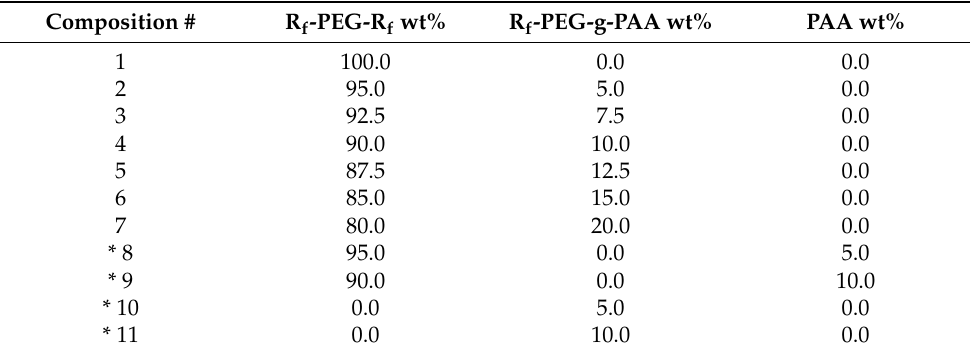
Table 1. Compositions of R f -PEG-g-PAA, R f -PEG-R f (fluoroalkyl double-ended poly(ethylene glycol)), and PAA (poly(acrylic acid)) in the lyophilized solid mixtures to make the co-hydrogels. Composition